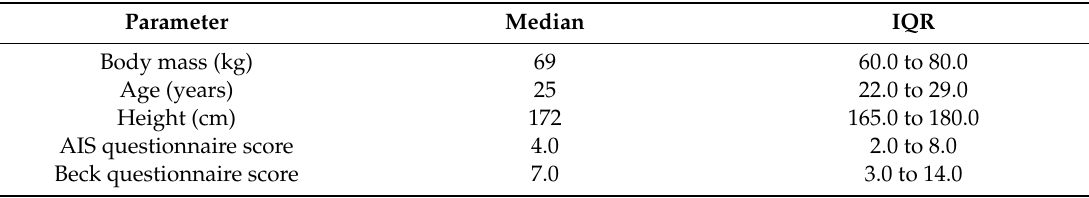
Table 2. Characteristics of the study